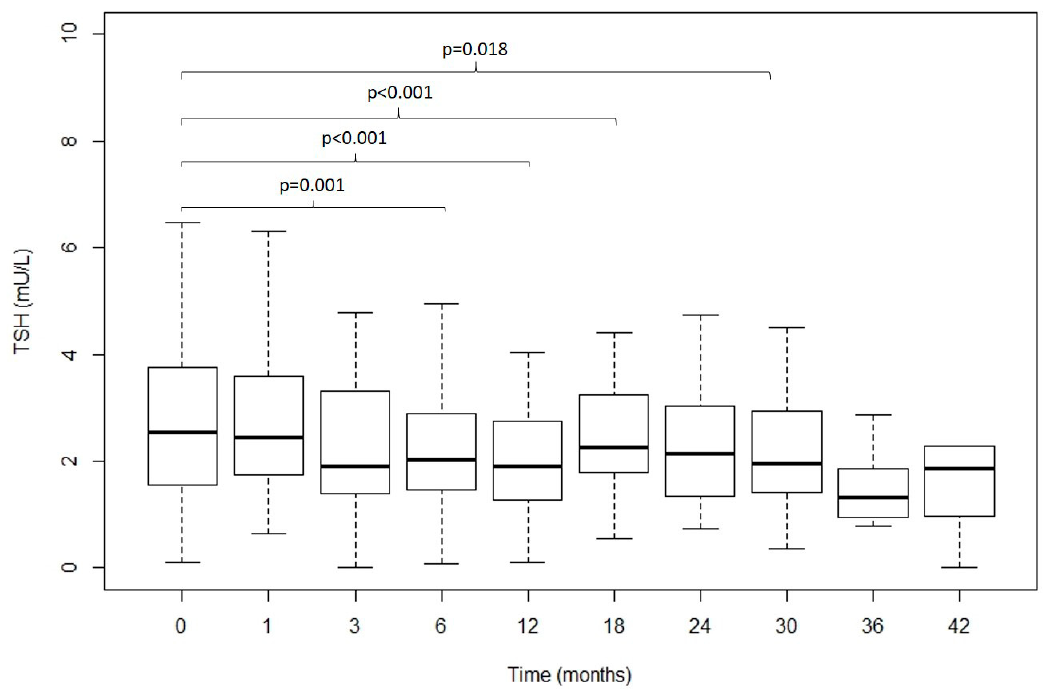
Figure 2. Evolution over time of TSH (median (IR)) before and after surgery (0, 1, 3, 6, 12, 18, 24, 30, 36, 42 months). Di ff erences were assessed by Student’s t -test for normally distributed data, and the Mann-Whitney test was used for comparison of medians. p -values < 0.05 were considered as statistically significant.